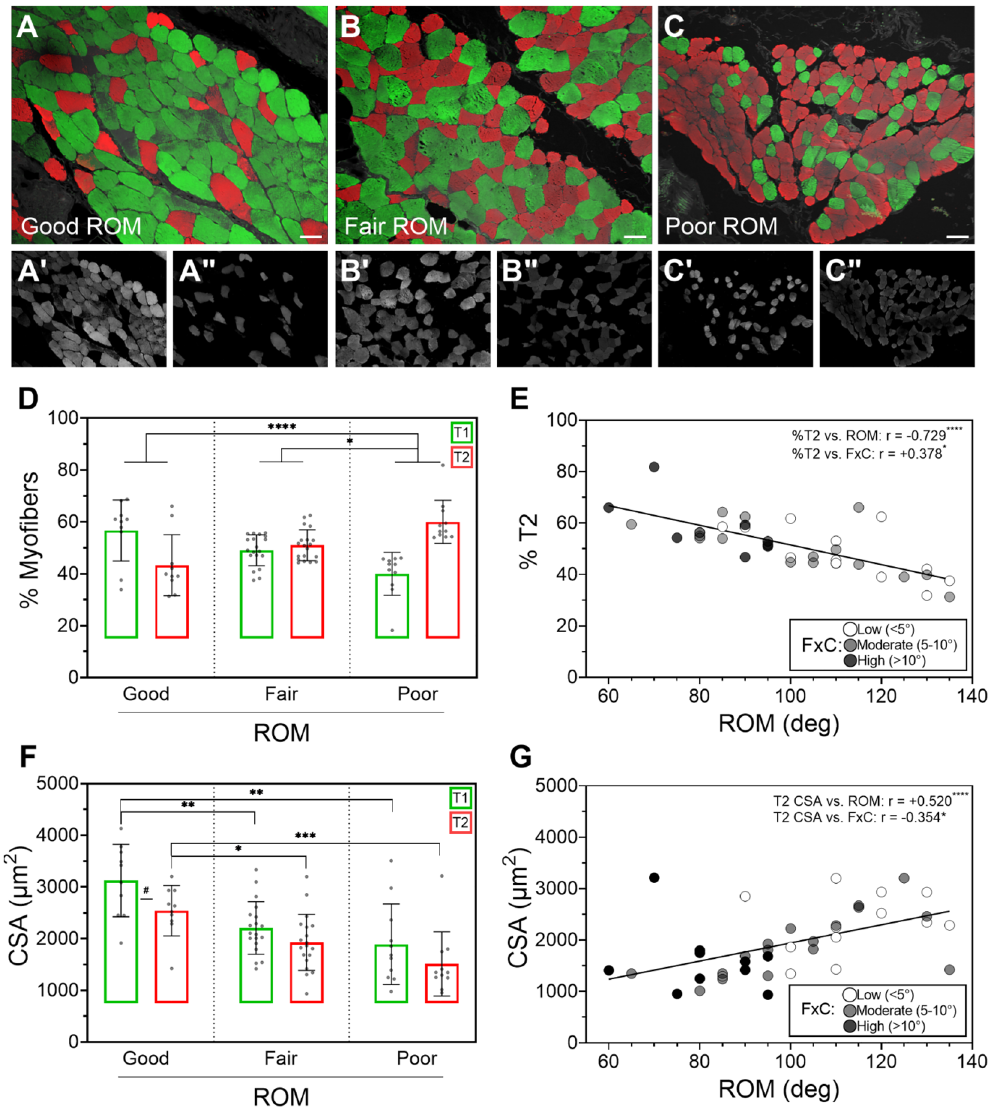
Figure 1. Myofiber distribution and CSA relative to ROM. Representative merged photomicrographs of co-labeled T1 (green), and T2 (red) myofibers in AG sections from ( A ) good, ( B ) fair, and ( C ) poor ROM patient groups were segmented by individual ( A ’– C ’) T1, and ( A ”– C ”) T2 grayscale channels for fiber count and CSA analyses using Slidebook 5 and Graphpad PRISM 9 software for morphometry and statistics, respectively. Bars = 50 µm. ( D ) Mean ± SD fiber counts between and within ROM groups. ( E ) Spearman’s ρ (r) was calculated between T2 (and correspondingly T1) fibers and total ROM. Data points were shaded according to severity of FxC, and r calculated between FxC and T2 content. ( F ) Mean CSAs were compared within and between ROM groups and ( G ) tested for associations with both total ROM and FxC. * p < 0.05 between groups and # p < 0.05 within groups; ** p < 0.01; *** p < 0.001; and **** p <